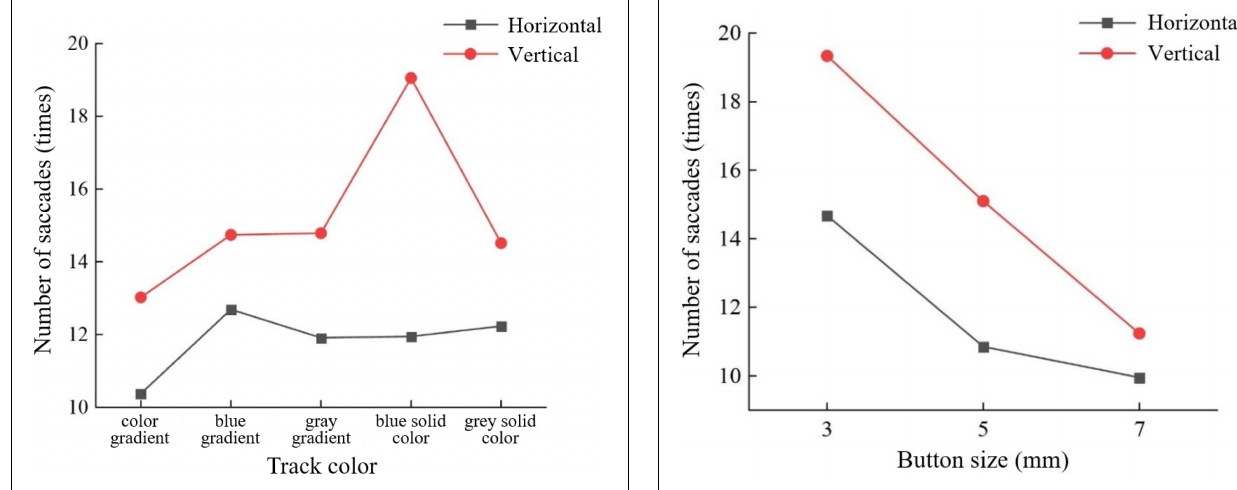
FIGURE 4 | Number of saccades by button size and sliding orientation for the young